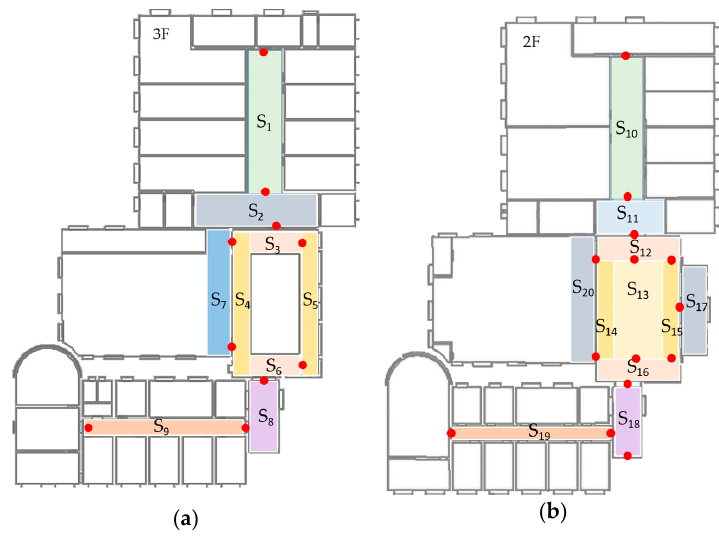
Figure 11. Definition of scene labels and transition points. ( a ) There are ten TPs and nine scenes in third floor; ( b ) 14 TPs and 11 scenes in second floor respectively.